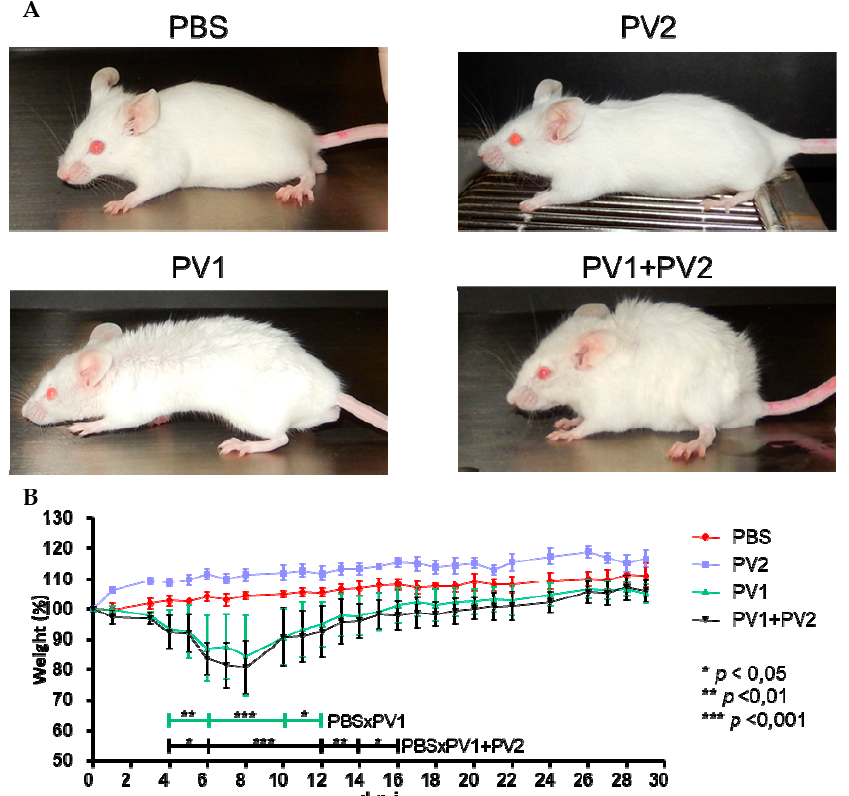
Figure 3. Clinical signs of Balb/c mice coinfected and monoinfected with PV1-GII and PV2-GI. Five-week-old male Balb/c mice were intranasally inoculated with 10 µL of viral suspension: PV1-GII 1 × 10 6 p.f.u.; PV2-GI 1 × 10 6 p.f.u.; PV1-GII + PV2-GI 5 × 10 5 p.f.u. of each sample; and a negative control group was inoculated with 10 µL of PBS. Clinical signs were observed on day 5 p.i and were recorded for 30 days post infection (d.p.i.). ( A ) In PBS and PV2-GI groups, no clinical signals were observed. Mice monoinfected with PV1-GII and coinfected (PV1-GII + PV2-GI) showed fur ruffling and hunching of the back. ( B ) The mice were daily weighed and relative mean weight was calculated. The error bars indicate standard deviations. PV1-GII: Pelotas virus 1 Group II; PV2-GI: Pelotas virus 2 Group I; PBS: phosphate-buffered saline. Asterisks indicate a statistically significant difference: * p < 0.05; ** p < 0.01; *** p < 0.001.